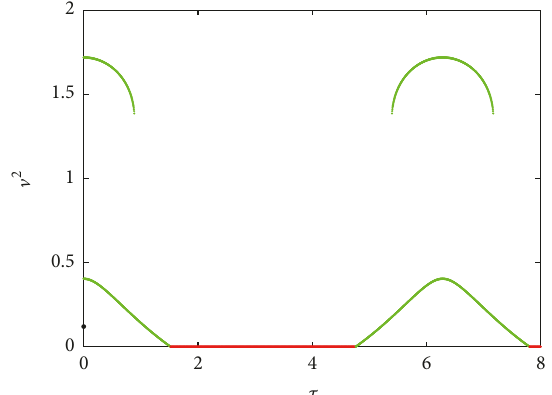
Figure 6: The dependence of the electric voltage V 2 on 𝜏 .